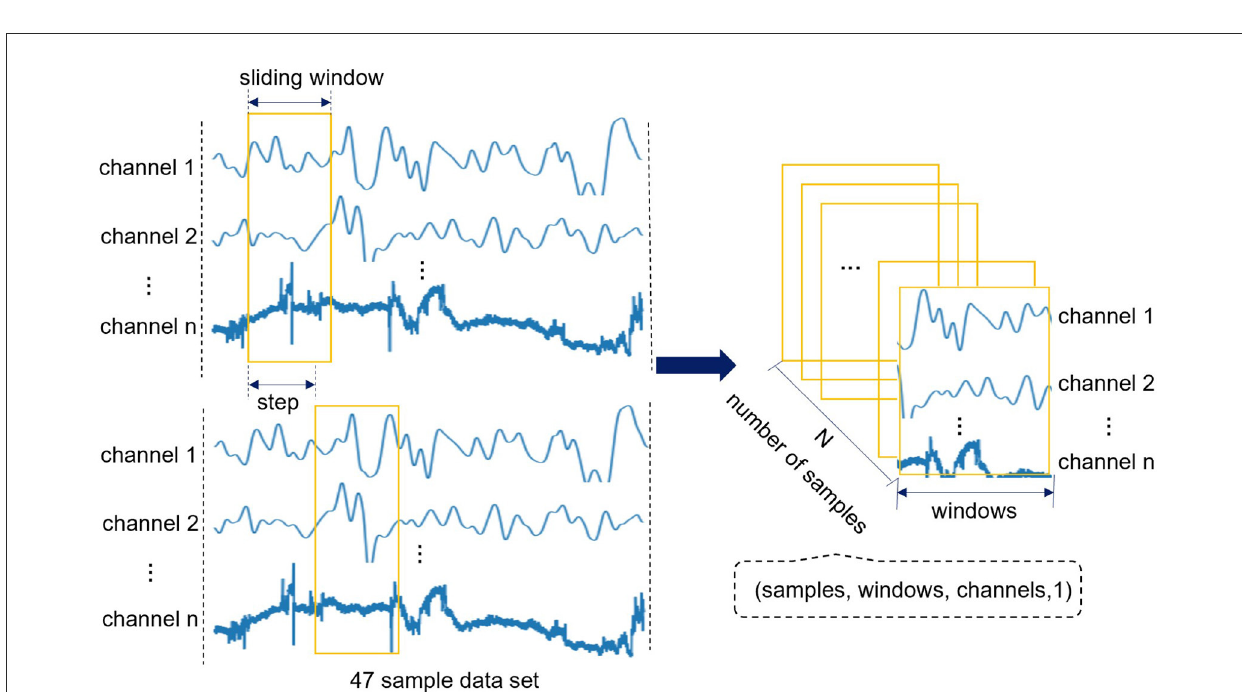
FIGURE2 The specific process of fNIRS dataset extraction and reconstruction. This process sets the sliding window to traverse 47 sample data, and finally the format of original fNIRS data becomes four-dimensional tensor (samples, windows, channels, 1).